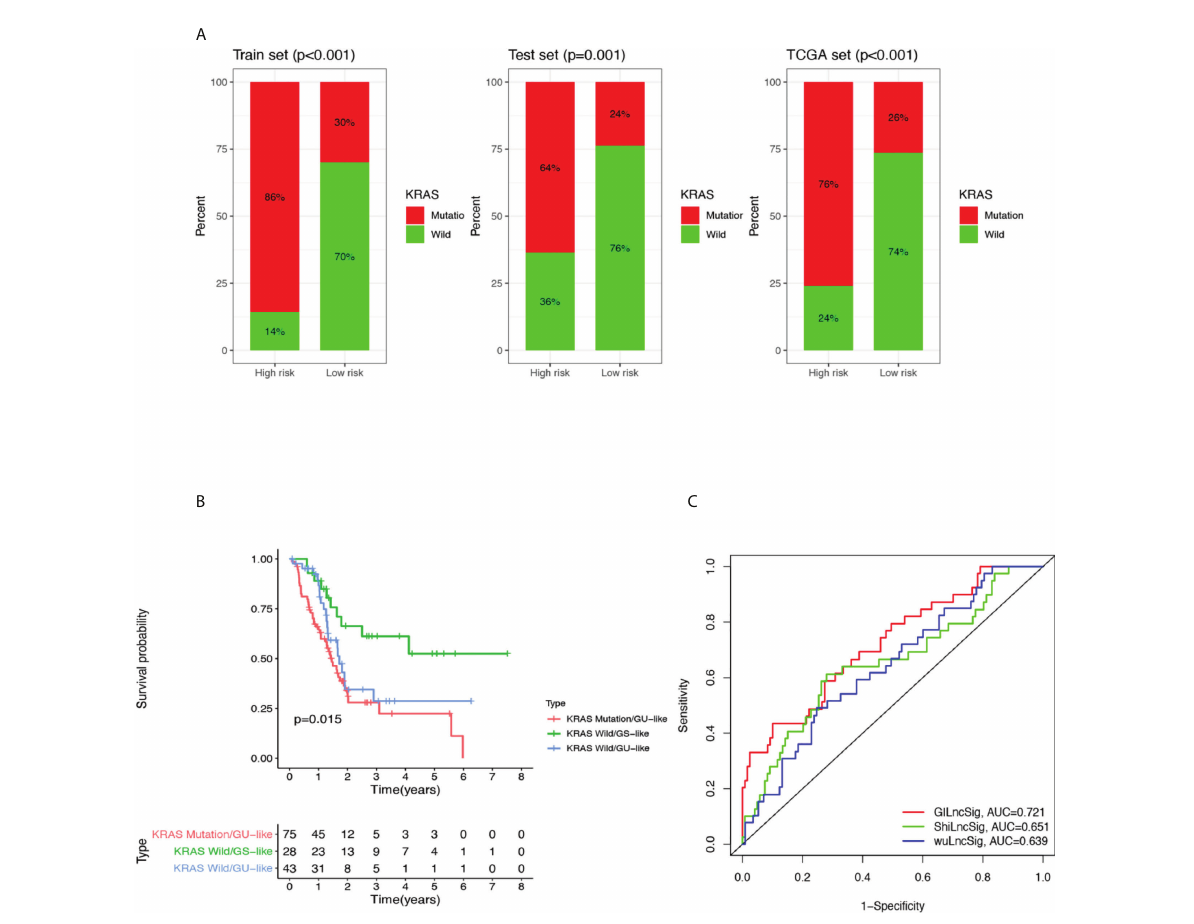
FIGURE 4 Performance comparison of GILncSig with KRAS paradigm and lncRNA-related prognostic models derived from other studies. (A) The proportion of KRAS mutations in high- and low-risk groups in the training set, testing set and the TCGA cohort. (B) Kaplan-Meier curve analysis of overall survival for PDAC patients belonging to KRAS Mutation/GU-like group, KRAS Wild/GU-like group and KRAS Wild/GS-like group for patients classi fi ed by KRAS mutation status and GILncSig. Statistical analysis was performed using the log-rank test. (C) The ROC analysis at 3 years of overall survival for GILncSig, WuLncSig, and